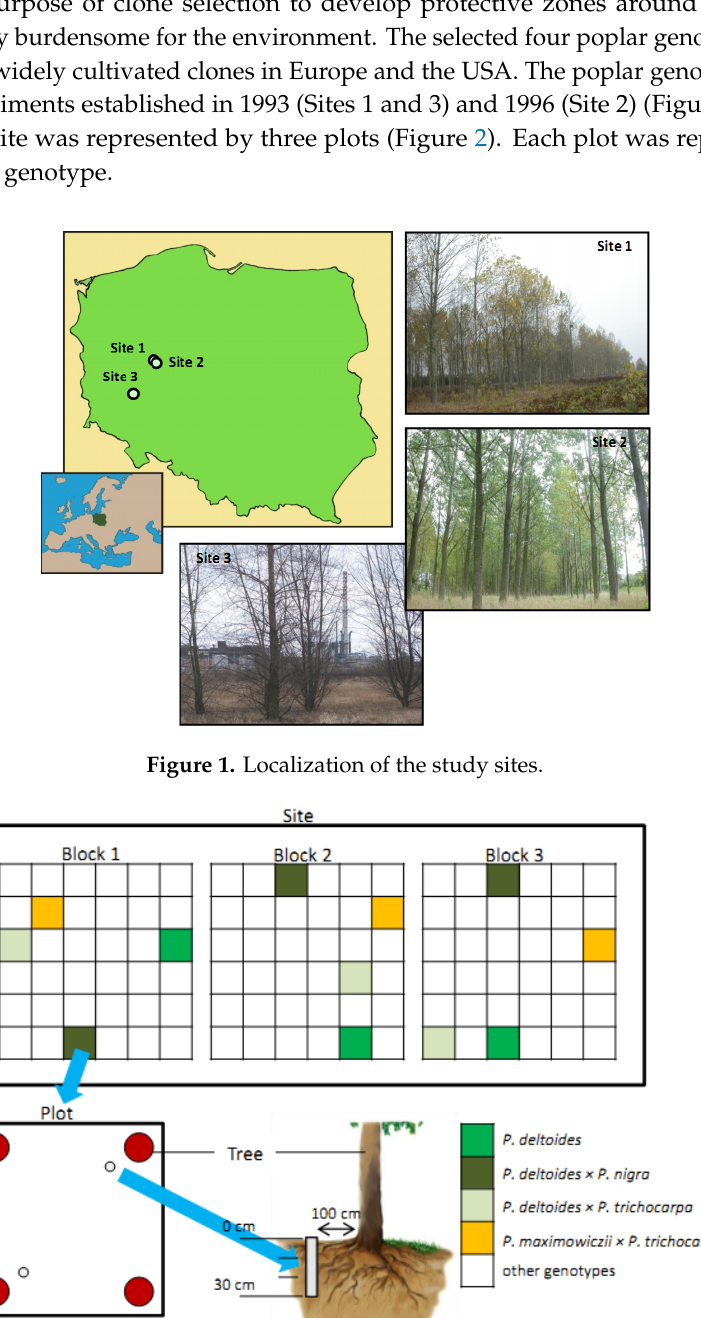
Figure 2. Study site and sampling scheme.